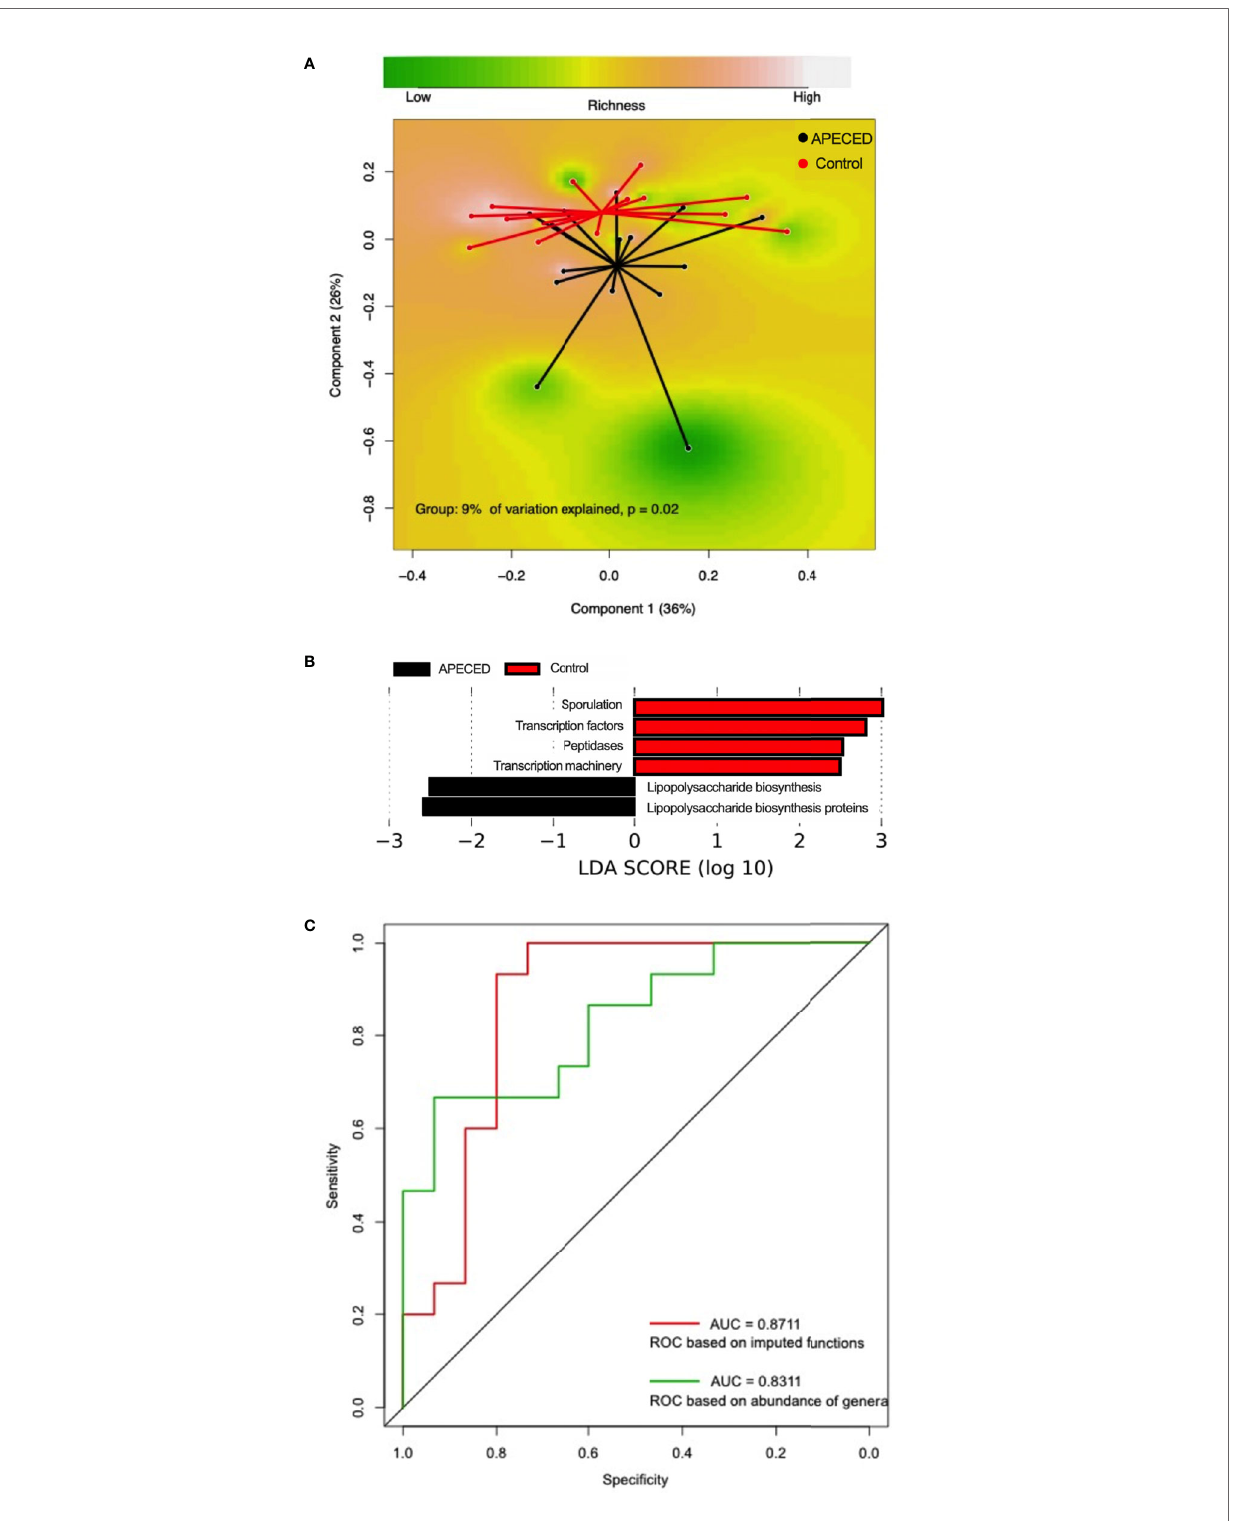
FIGURE 3 | (A) Principal coordinate analysis (PCoA) based on Bray – Curtis distances using the predicted functional modules showing differences in the gut microbiota compositions between patients with APECED (black) and healthy controls (red). (B) Predicted functional modules signi fi cantly overrepresented in patients with APECED (black) and controls (red). (C) Receiver operating characteristic (ROC) curves of the cross-validated random forest models constructed using the imputed functions (red) and relative abundances of genera